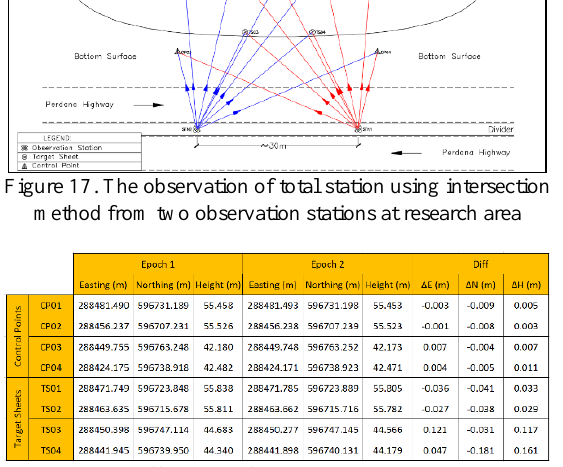
Table 3. The differences of intersection result between both epochs